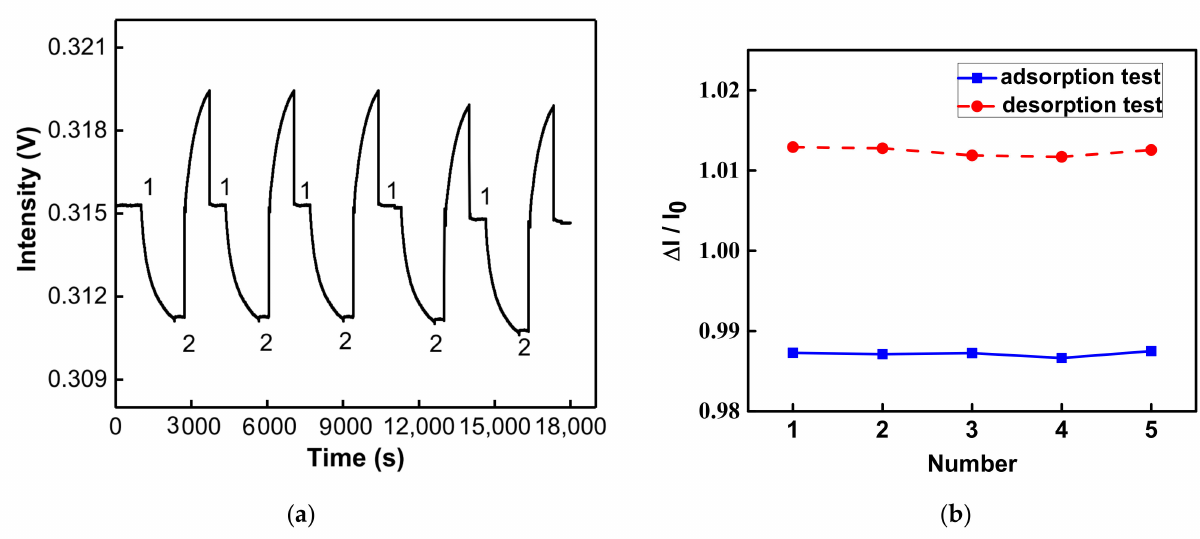
Figure 9. Regeneration study of anti-IgG-functionalized GO-OW sensor chips. ( a ) Adsorption and desorption real-time signal response (No. (1) is to inject the IgG; No. (2) is to inject the glycine buffer). ( b ) Relative signal response values for adsorption and desorption tests (sample numbers =